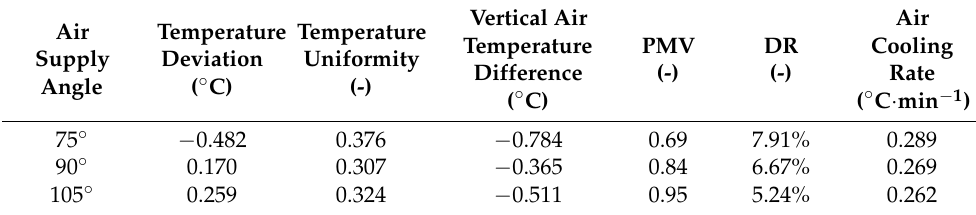
Table 10. Effects of the air supply angle on the thermal